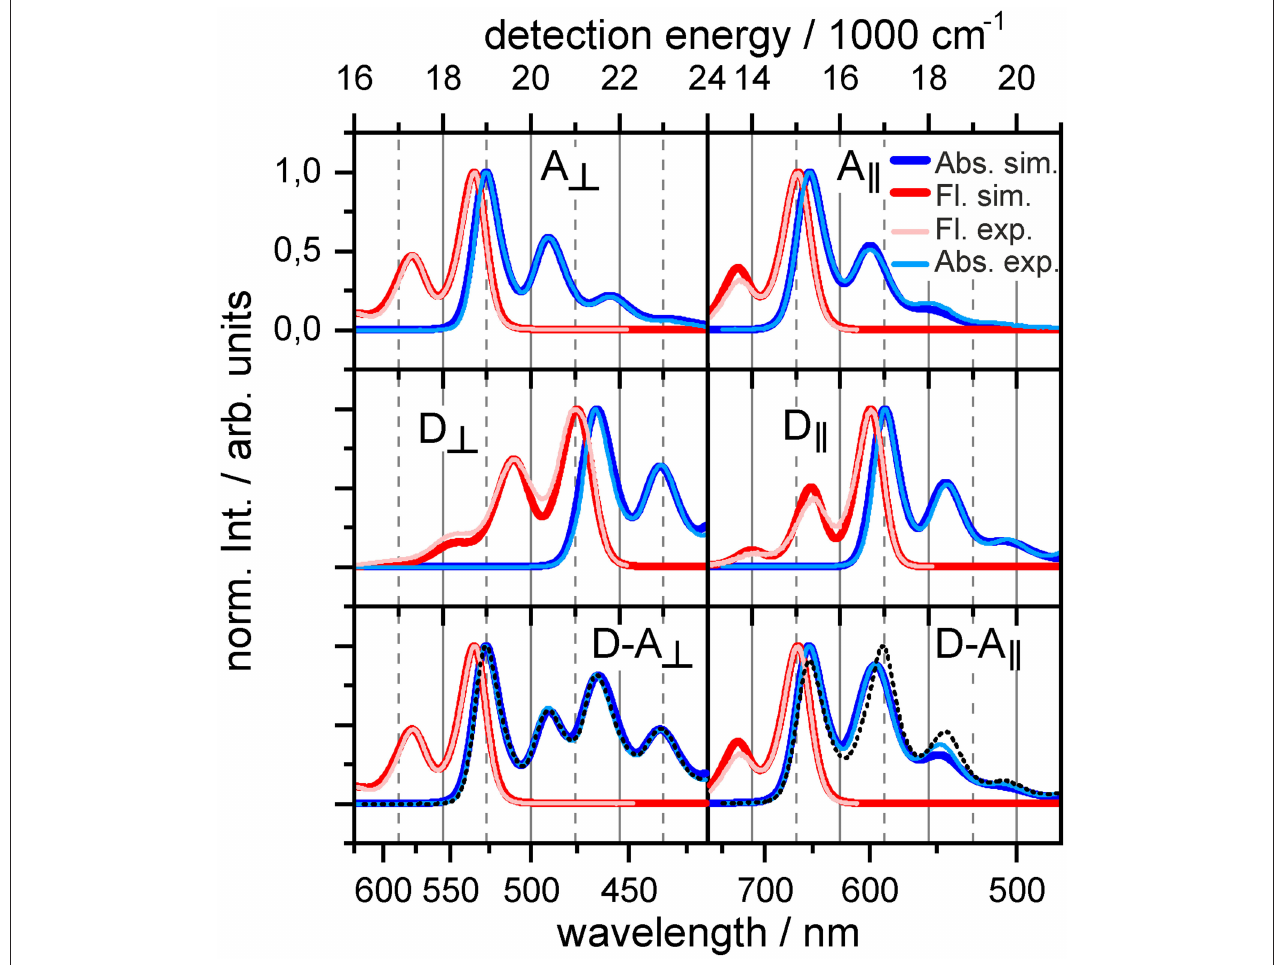
FIGURE 2 | Experimental and simulated absorption (blue lines) and fluorescence (red lines) spectra for acceptor (top) , donor (middle) , and dyad (bottom) . The dashed black line combines absorption of donor and acceptor S A + S D . Left: Orthogonal dyad. Right: Parallel